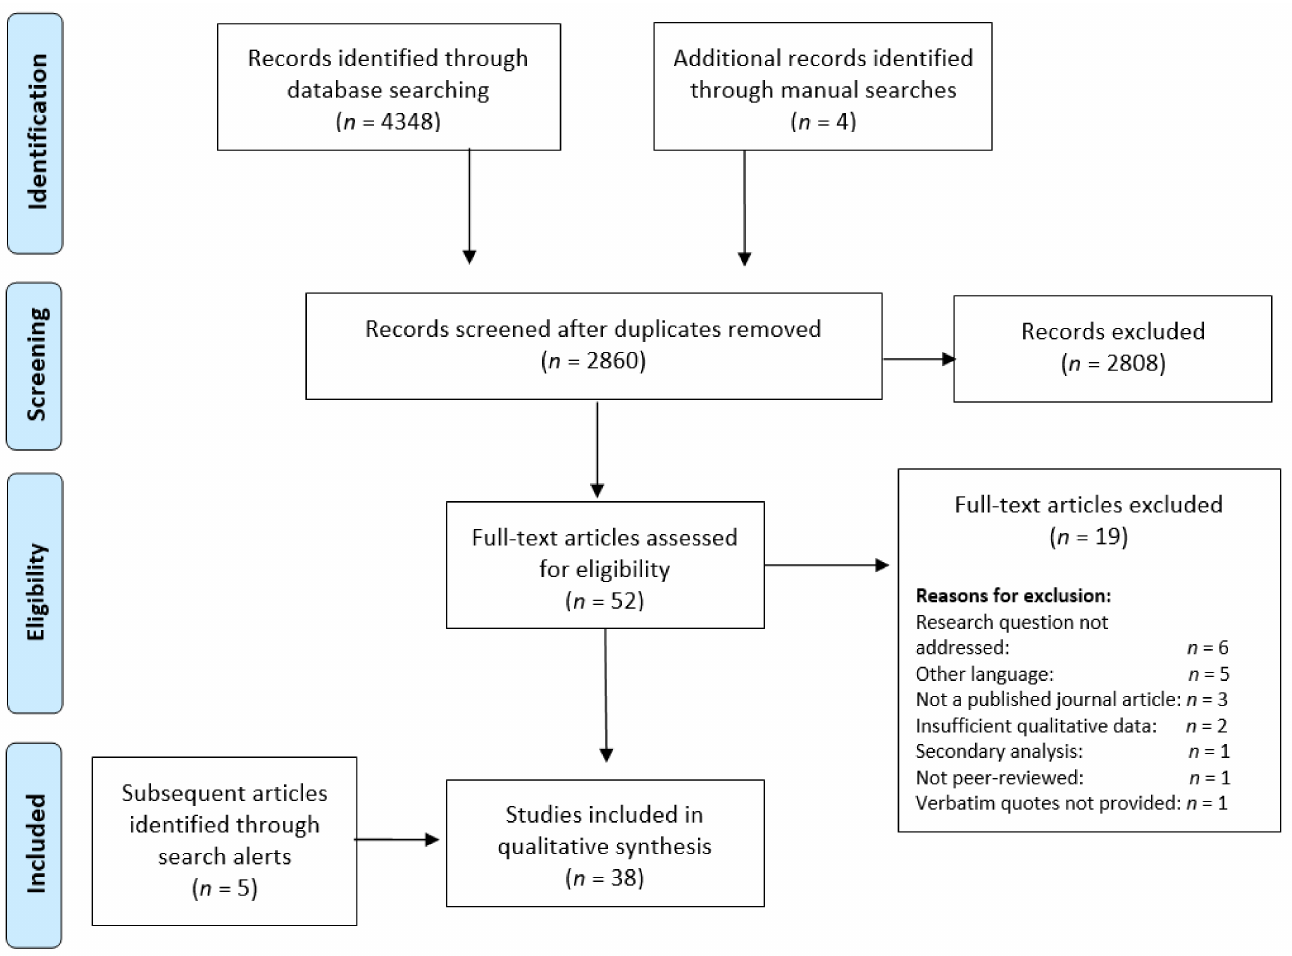
Figure 1. PRISMA flow diagram of the selection process. Adapted from the Preferred Reporting Items for Systematic Review and Meta-analyses (PRISMA) flow diagram